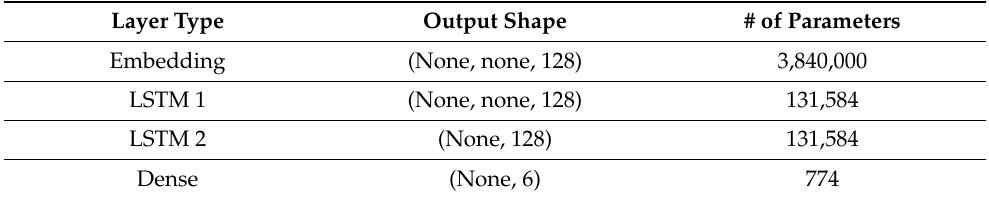
Table 4. LSTM model on the Google Jigsaw